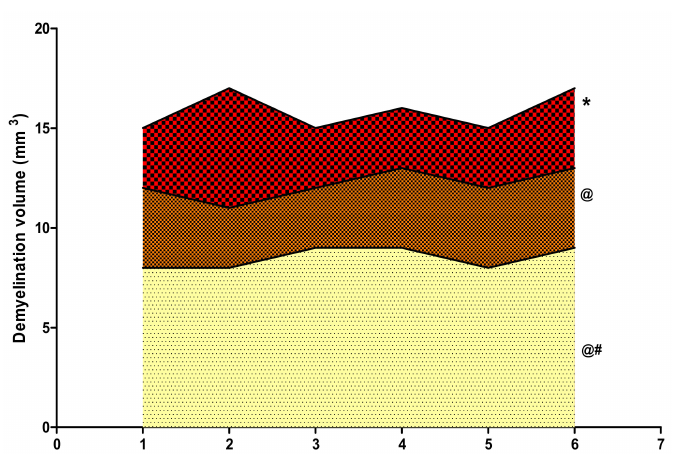
Figure 17. Effect of 4-hydroxyisoleucine on demyelination volume after methyl mercuryexposure in rats. Statistical analysis by one-way ANOVA (posthoc Tukey’s test). Values are expressed as mean ± SEM ( n = 6 rats per group). * p < 0.001 v/s normal control, vehicle control and 4-HI100 perse ; @ p < 0.001 v/s MeHg5; @# p < 0.001 v/s MeHg5 +